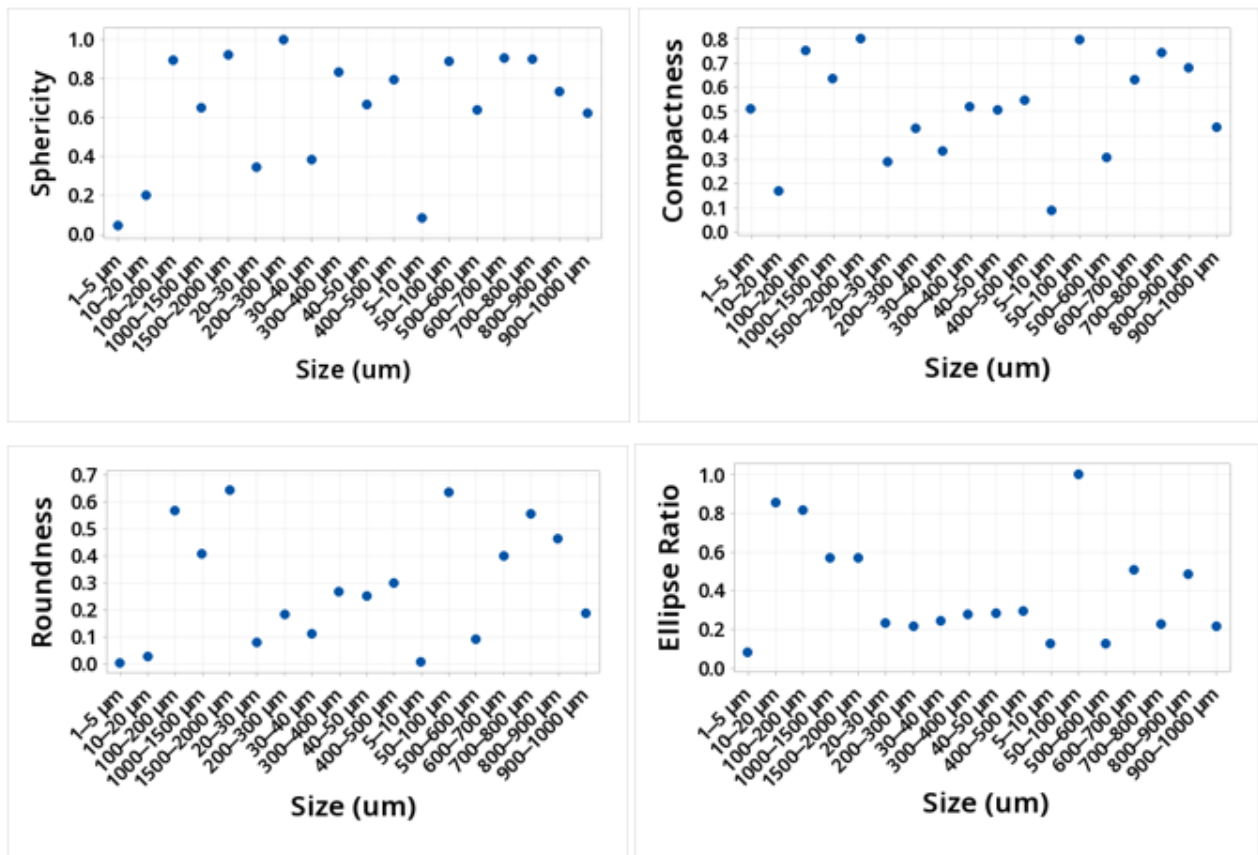
Figure 3. Values of sphericity, compactness, roundness, and ellipse ratio of the MPs identified.